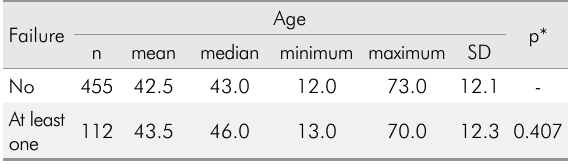
Table 1. Distribution of patients according to sex, age and craniofacial pattern.